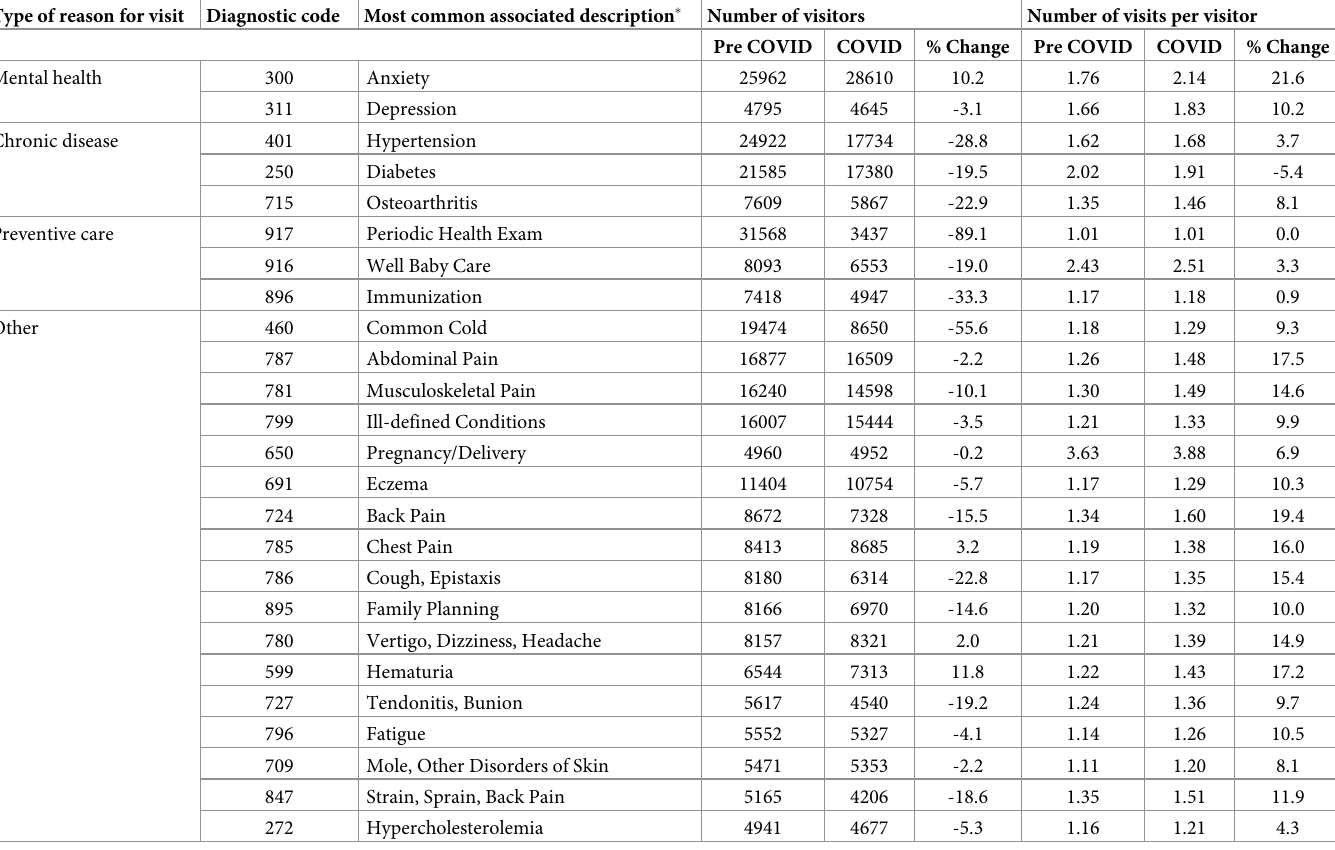
Table 3. Number of visitors and visits per visitor by reason for visit. Type of reason for visit Diagnostic code Most common associated description